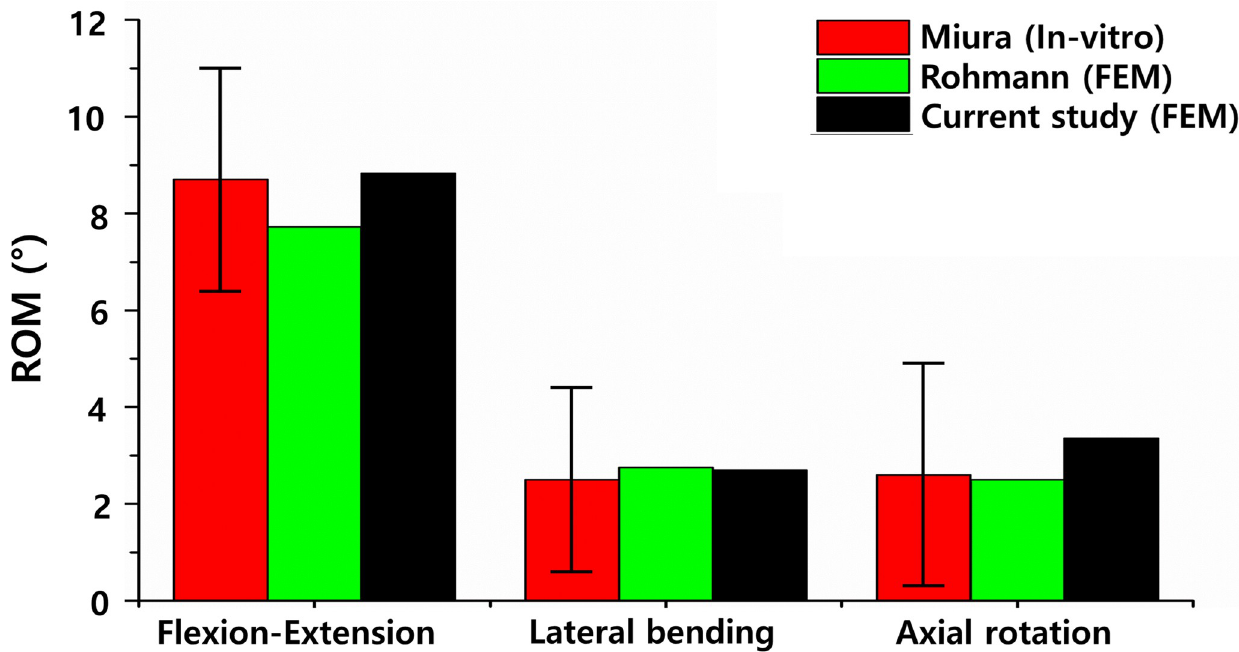
Fig 7. Range of motion (ROM) of the degenerative L3-L4 lumbar spine with degenerative disc disease under pure moment (10 N � m) in flexion– extension, lateral bending, and axial rotation.